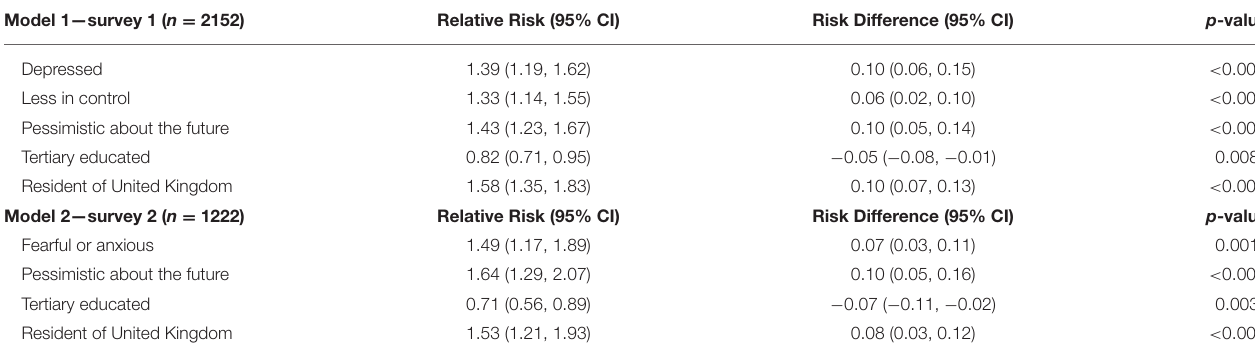
TABLE 4 | * Independent predictors of alcohol stockpiling in midlife women in Australia and the United Kingdom—May and July 2020. Model 1—survey 1 ( n =